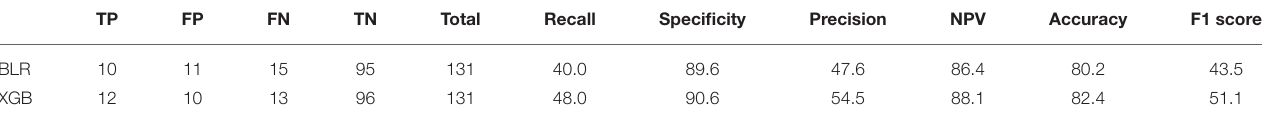
TABLE 4 | Results of classification performance of binary logistic regression and extreme gradient boosting to predict 3-month poor outcome of AIS patients in the test data. TP FP FN TN